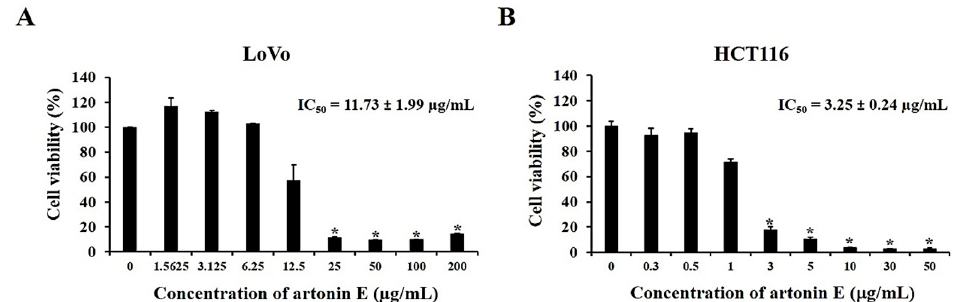
Figure 1. Effect of artonin E on cell viability following treatment with different concentrations of artonin E for 24 h: ( A ) LoVo cells and ( B ) HCT116 cells. The data are presented as mean ± SD (n = 3). * p < 0.05 compared with the control group.